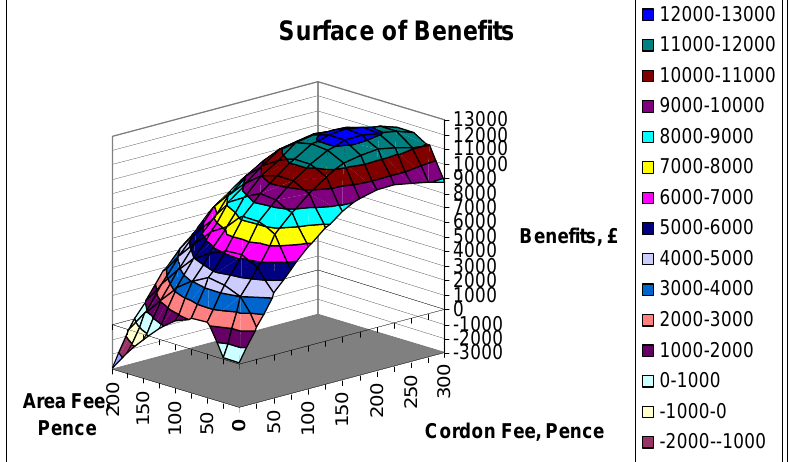
Figure 3. Benefits as cordon and area fee are